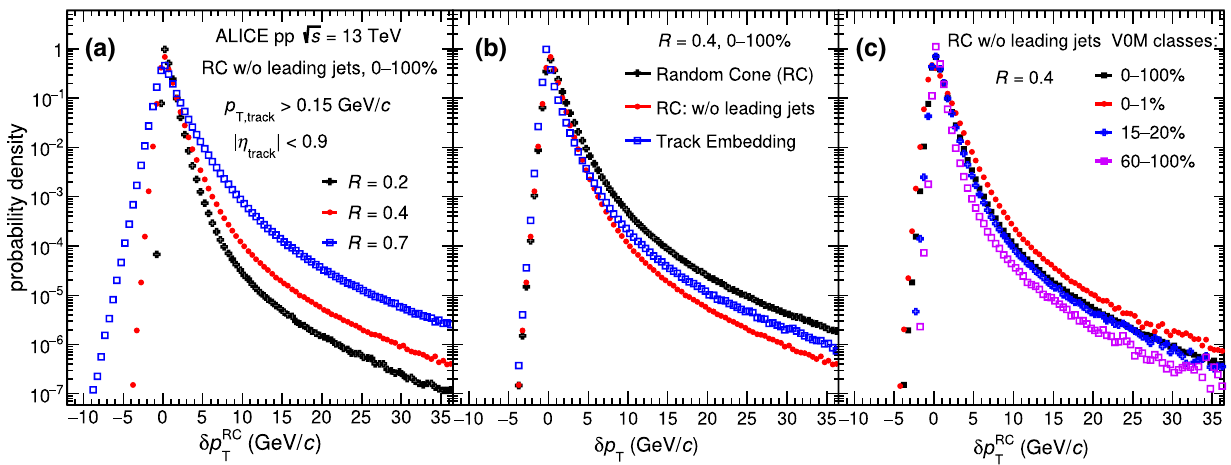
Fig. 2 a Comparison of the δ p T distribution obtained for different ran- dom cone radii ( R = 0 . 2 , 0 . 4 , 0 . 7). b Comparison of the δ p T distribu- tion with the RC method (including and excluding two leading jets) and